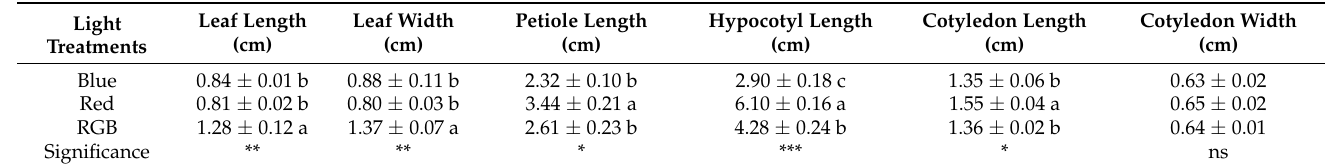
Table 1. Morpho-metric measurements of parsley microgreens with reference to the different light treatments (red, blue and RGB).